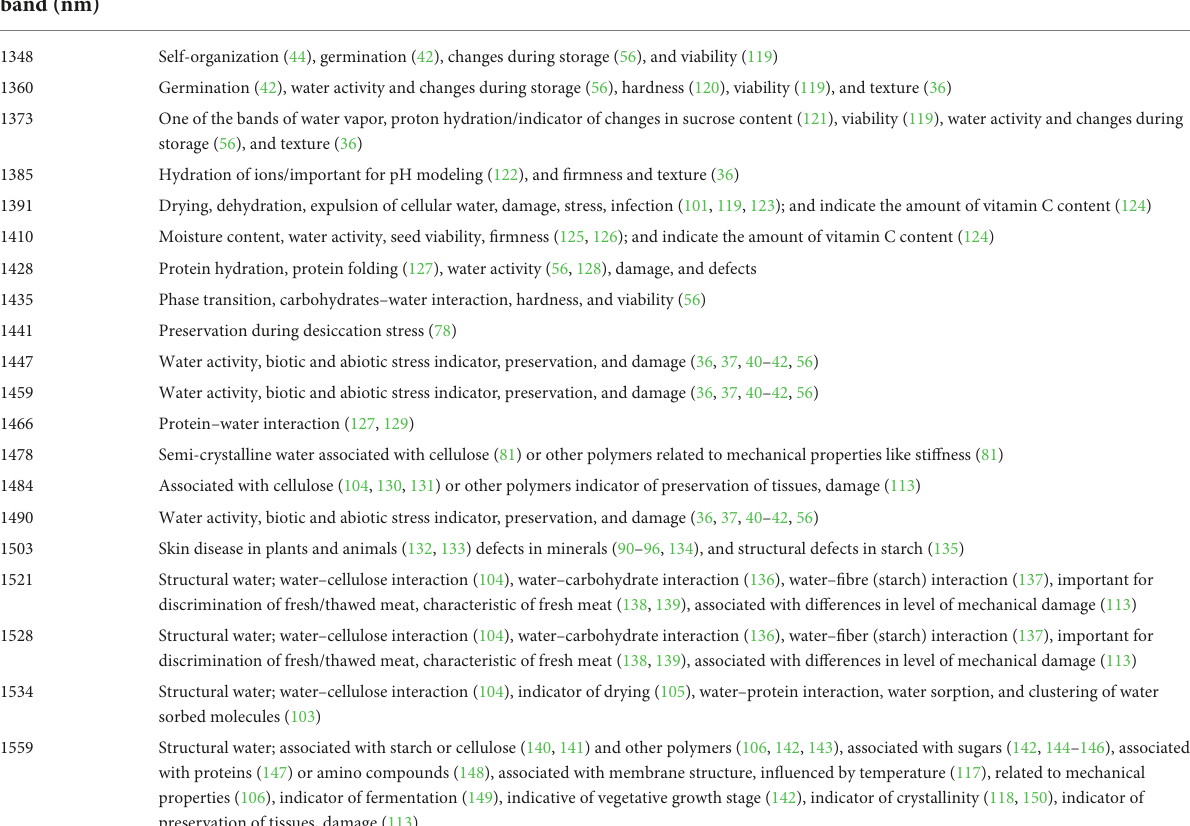
TABLE 2 Water matrix coordinates (WAMACS) that can be used to describe the changes during post-harvest ripening of strawberries during cold storage. Absorbance band